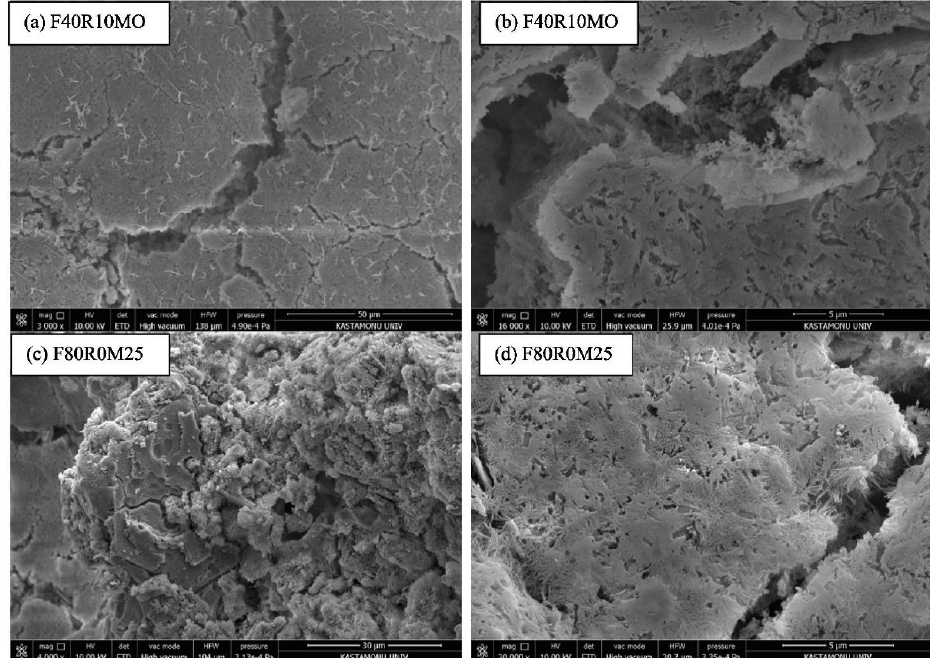
Figure 11. SEM images of foam concrete samples exposed to 800 ◦ C. Reprinted/adapted with permission from Ref. [18]. 2021, Elsevier Science &Technology